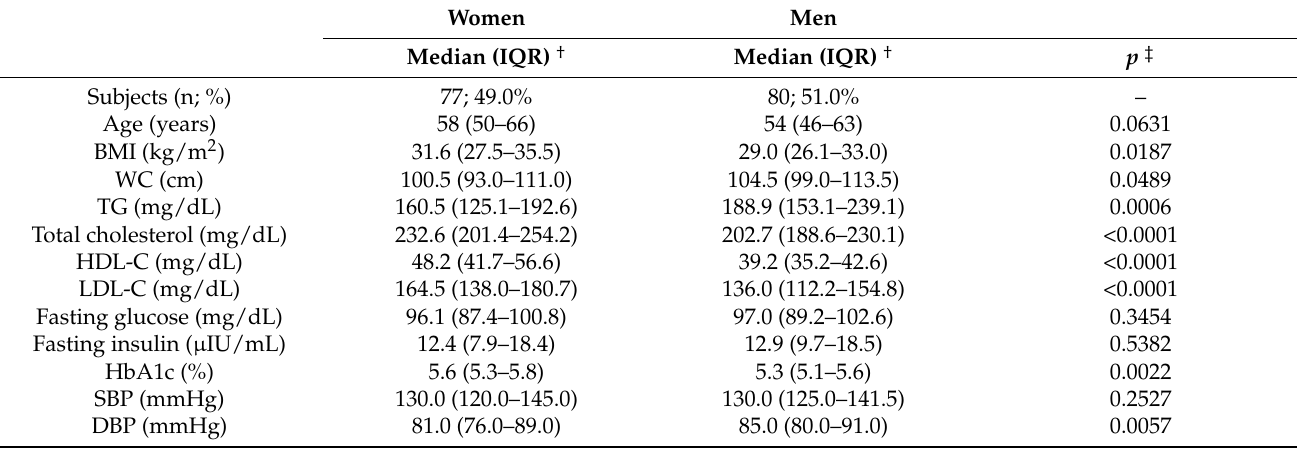
Table 1. General characteristics of the study population grouped by gender (medians and interquartile ranges, IQR).